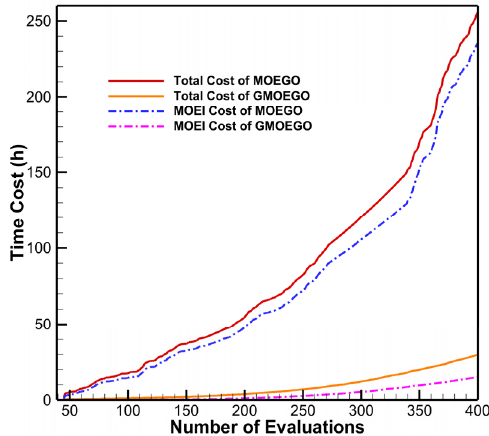
Figure 15. Time cost histories.